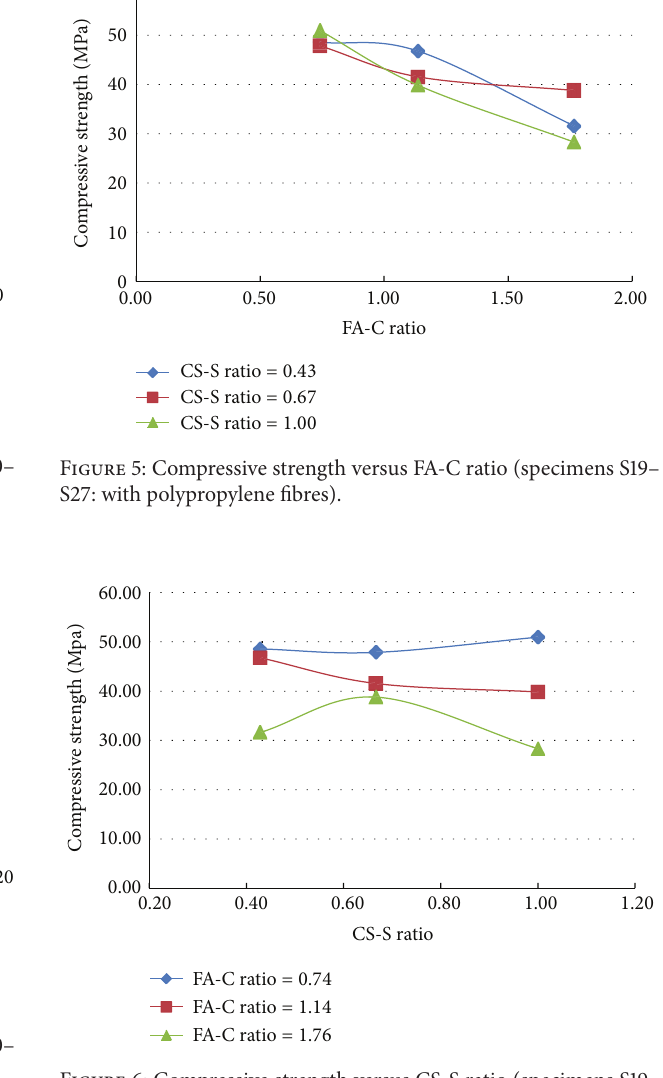
Figure 6: Compressive strength versus CS-S ratio (specimens S19– S27: with polypropylene fibres).